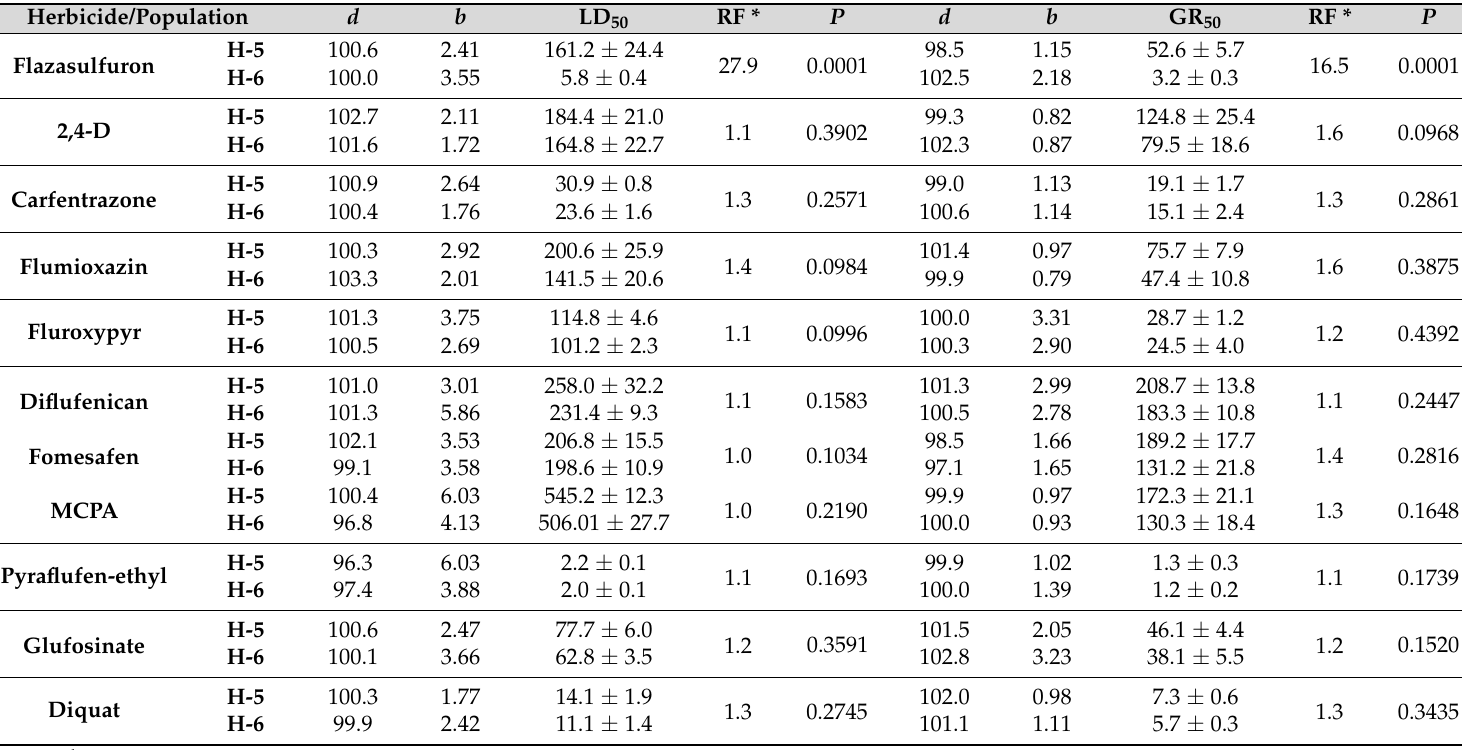
Table 5. Parameters of the log-logistic equations a used to calculate the herbicide rates (g ea ha − 1 ) required for 50% survival (LD 50 ), or reduction fresh weight (GR 50 ) of C. canadensis populations H-5 and H-6 from Hungary ( n =